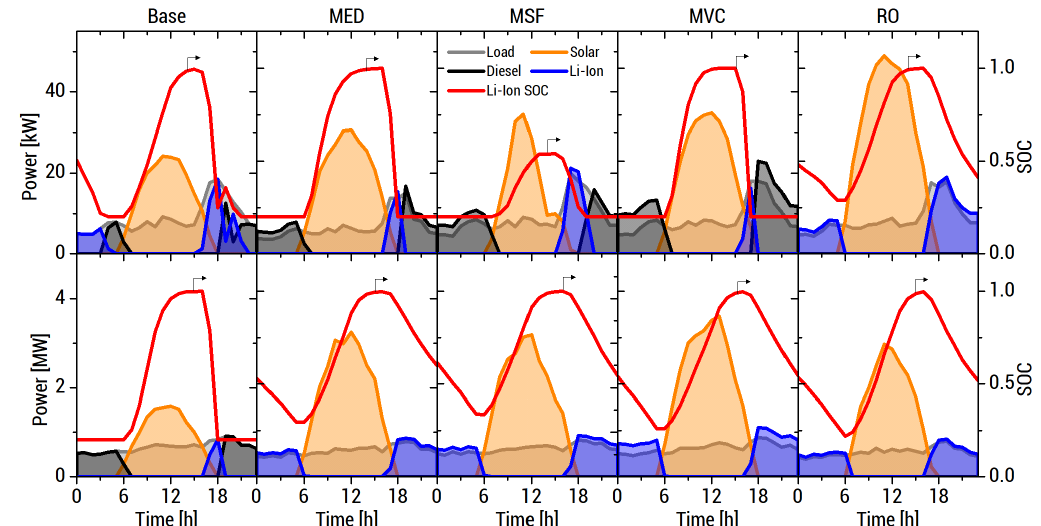
Figure 11. Hourly power output of electrical components and Li-ion BESS state of charge (SOC) on Camasusu Island (top) and Lubang Island (bottom). Li-ion BESS usage is high on Lubang Island. Energies 2020 , 13 , x FOR PEER REVIEW